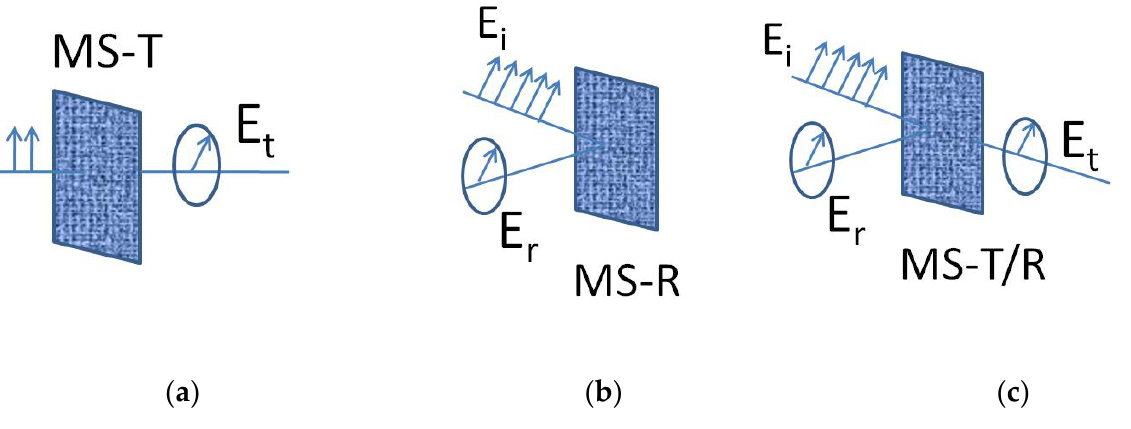
Figure 1. Selected polarization conversion functionalities of MS: ( a ) Transmissive polarization con- version ( b ) Reflective polarization conversion ( c ) Transmissive and reflective polarization conver- sion.